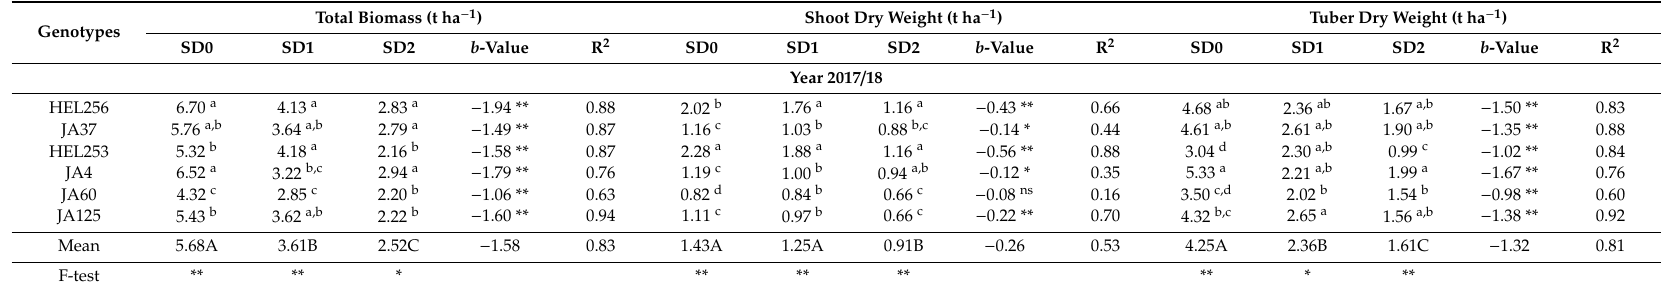
Table 3. Total biomass, shoot dry weight, tuber dry weight, regression coe ffi cient ( b -value) and coe ffi cient of determinations (R 2 ) of six JA genotypes at harvest grown under three drought durations in years 2017 / 18 and 2018 / 19.